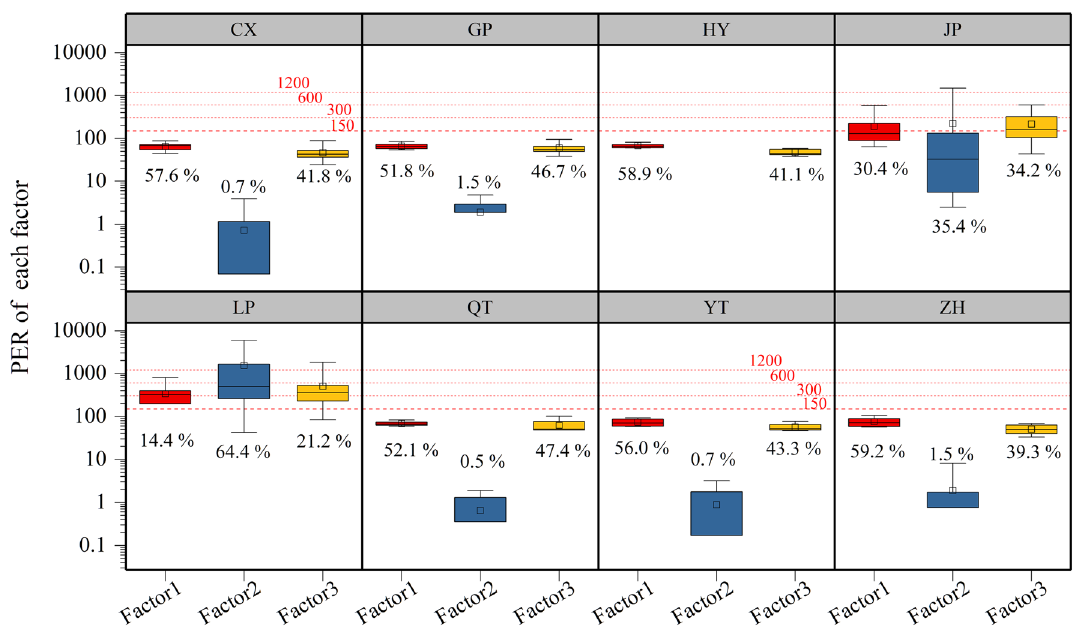
Figure 5. Contributions of various sources to PER. The red horizontal reference lines represent the corresponding classification criteria of PER (150, 300, 600,1200). Boxes represent the interquartile range (i.e., 25th and 75th percentiles), the hollow squares represent the average values, and the whiskers represent the 5th and 95th